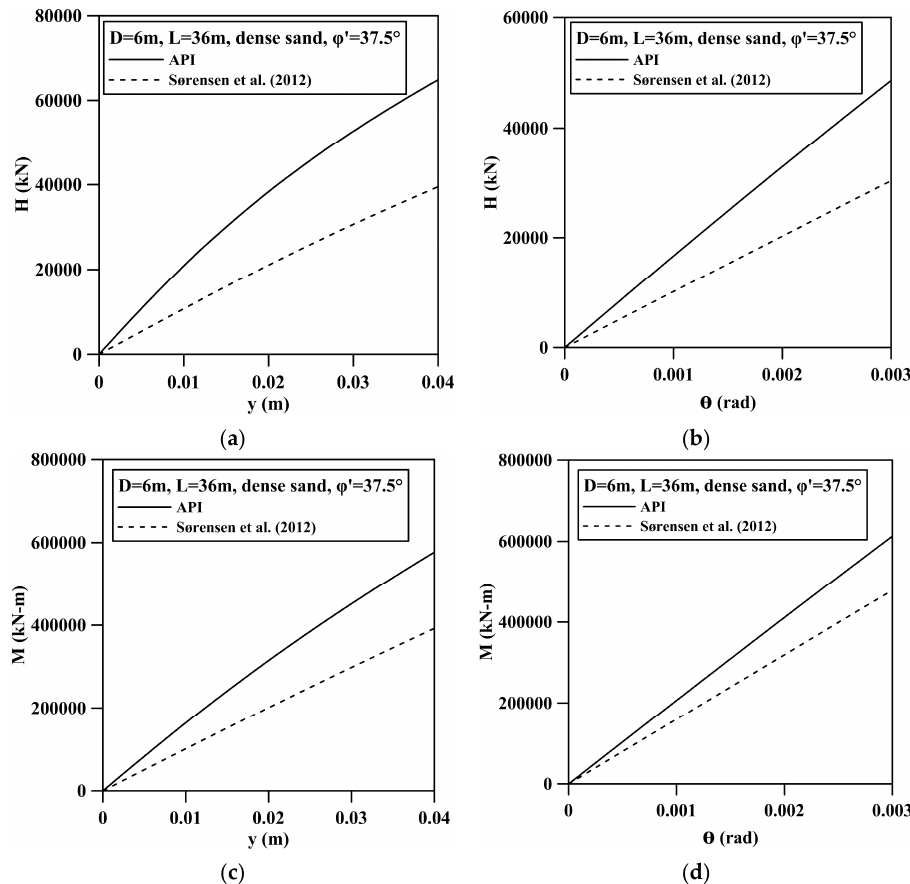
Figure 8. Load-displacement curve at pile head with D = 6 m and L = 36 m for dense sand. ( a ) y